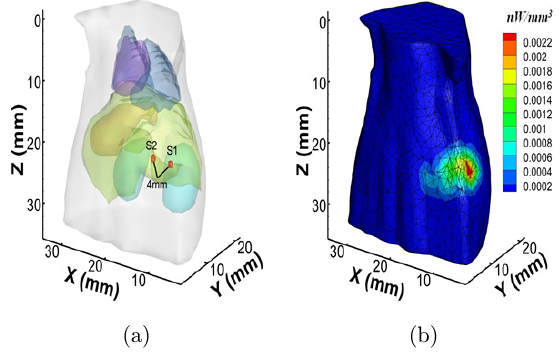
Fig. 6. (a) Source setting and (b) the simulated photon dis- tribution on the surface in double-source case.